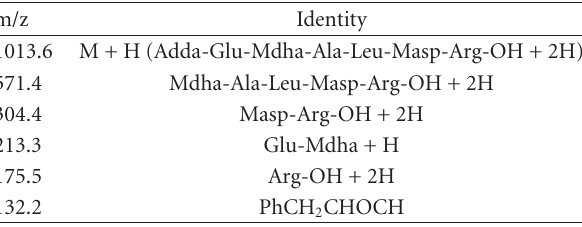
Figure 4: Mass spectrum of the primary degradation product of Sphingopyxis sp. strain C-1. The raw data obtained using mass spectrometry was treated by MacQuan and the figure shows only the main peaks. Table 1: Parent and daughter ions of the primary degradation